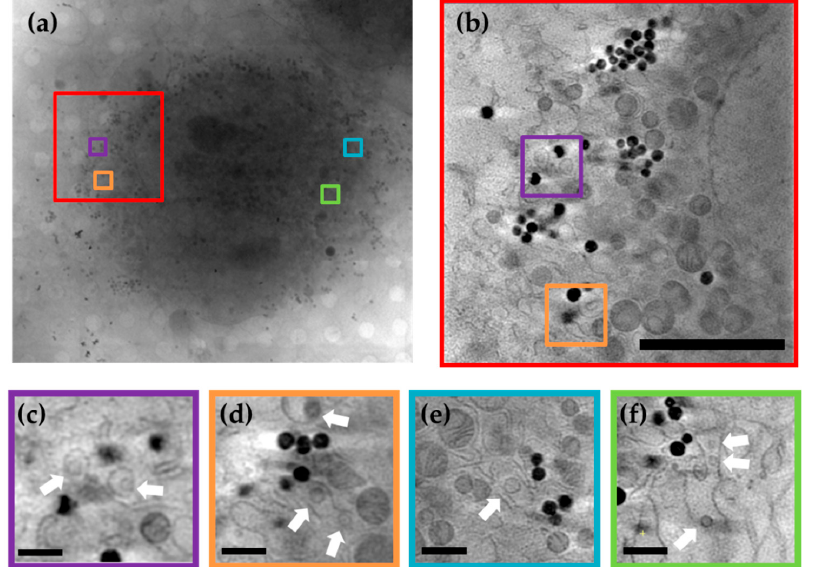
Figure 4. Imaging of Zika virus-induced ultracellular alterations by cryo-SXT. ( a ) X-ray mosaic showing a general view of two Zika virus-infected cells. ( b ) Frame corresponding to the 0º rotation of the tomogram acquired at the region indicated in red in ( a ). Scale bar corresponds to 5 µm. ( c – f ) Close-up views of different tomograms acquired from the cells in ( a ), in which a convoluted ER membrane and packets of replication vesicles (white arrows) can be observed, together with the associated mitochondria and electron-dense granules. Scale bar corresponds to 0.5 µm.